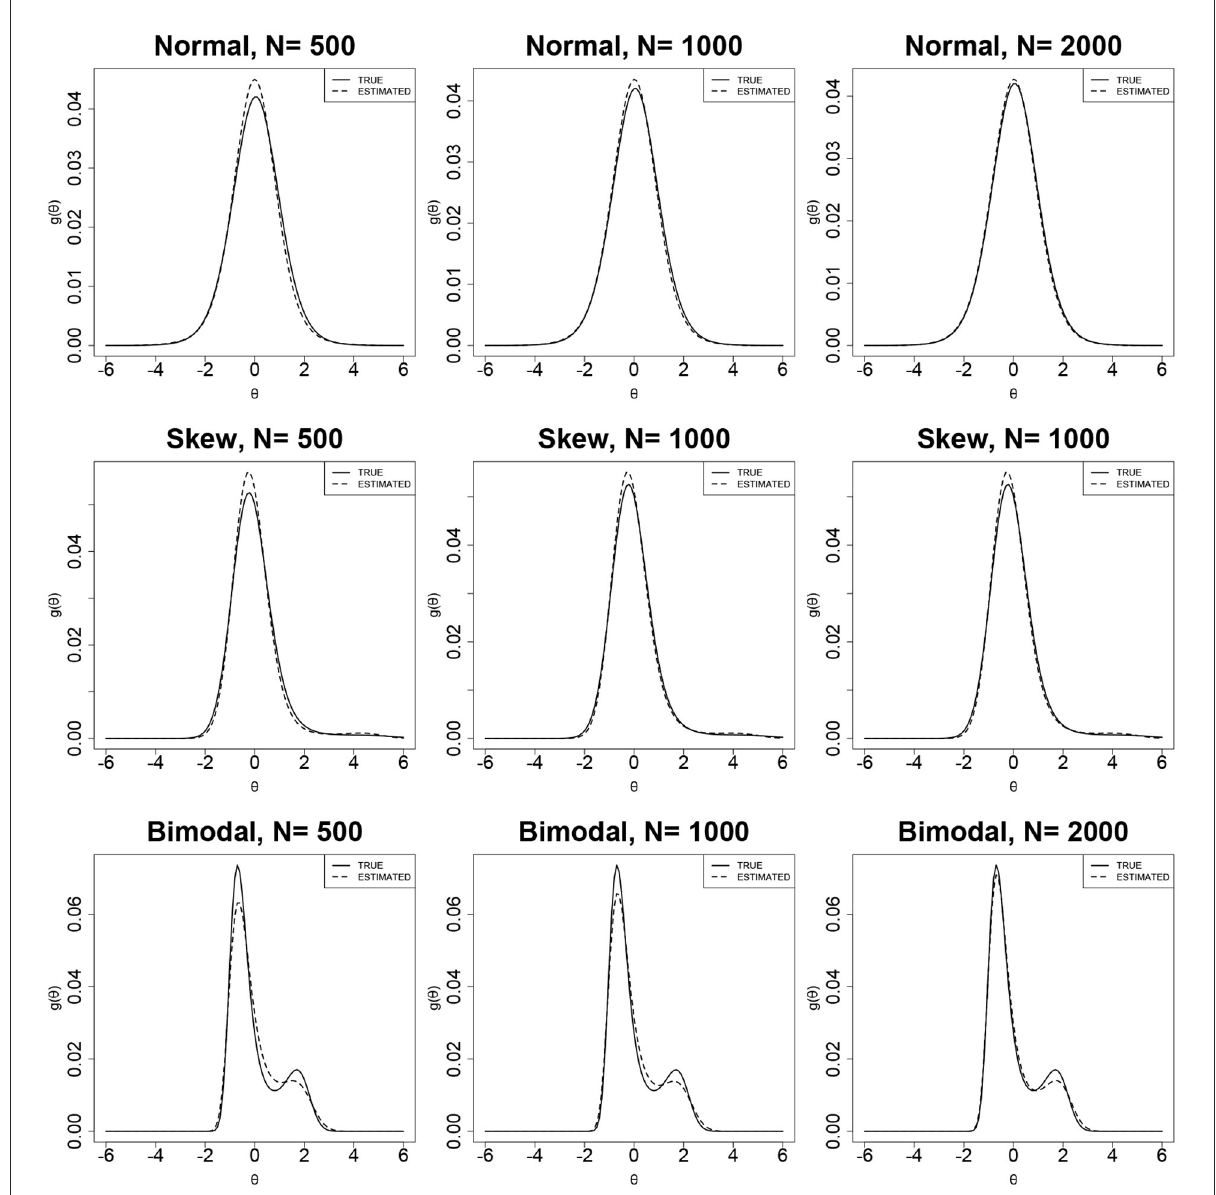
FIGURE4 True and estimated density curves using the RC-SAEM algorithm when test length is